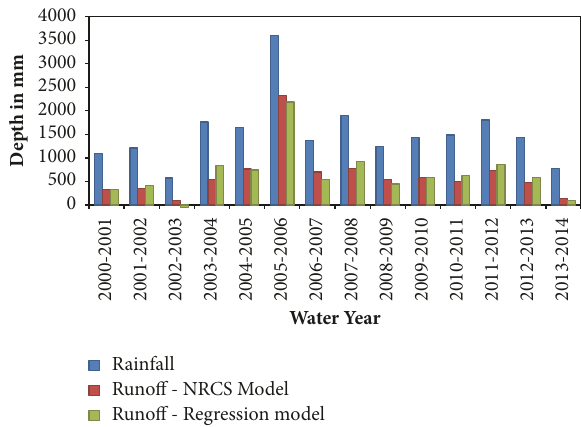
Figure 5: Annual rainfall and runoff for Urapakkam watershed.